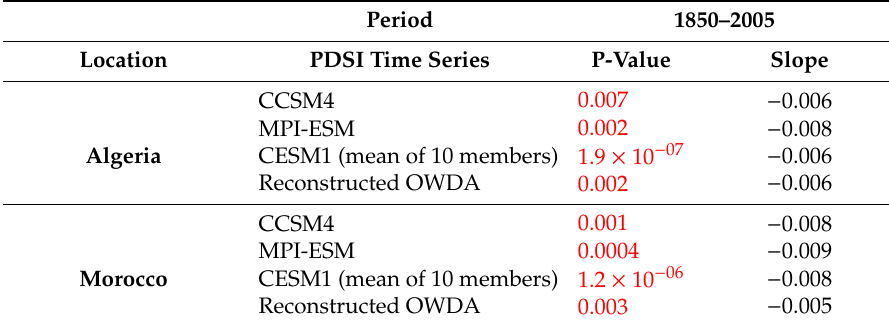
Table 6. Results of modified Mann–Kendall test of trend detection applied to Palmer Drought Severity Index PDSI simulated by CMIP5 models, reconstructed from Old World Drought Atlas (OWDA) over 1850–2005 in Morocco and Algeria. (Red indicates significance, with a p -value < 0.05.).